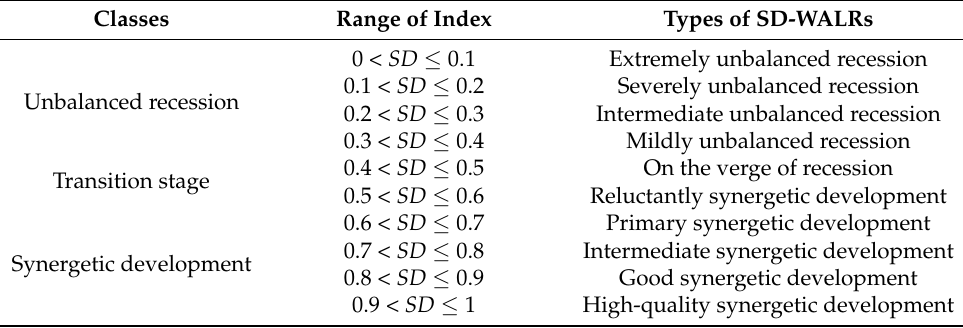
Table 3. Classification of the synergistic development